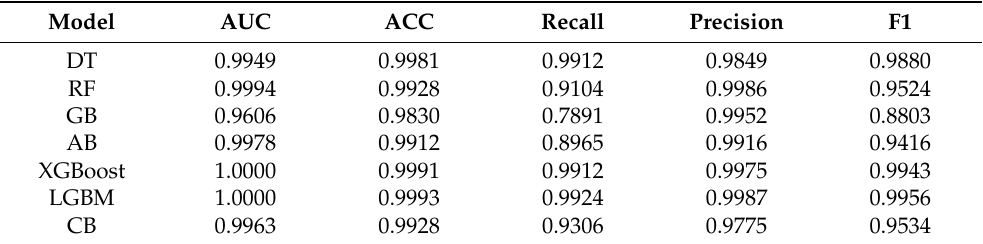
Table 9. Experiment IV: Testing results of the classifiers after TomekLinks algorithm using selected